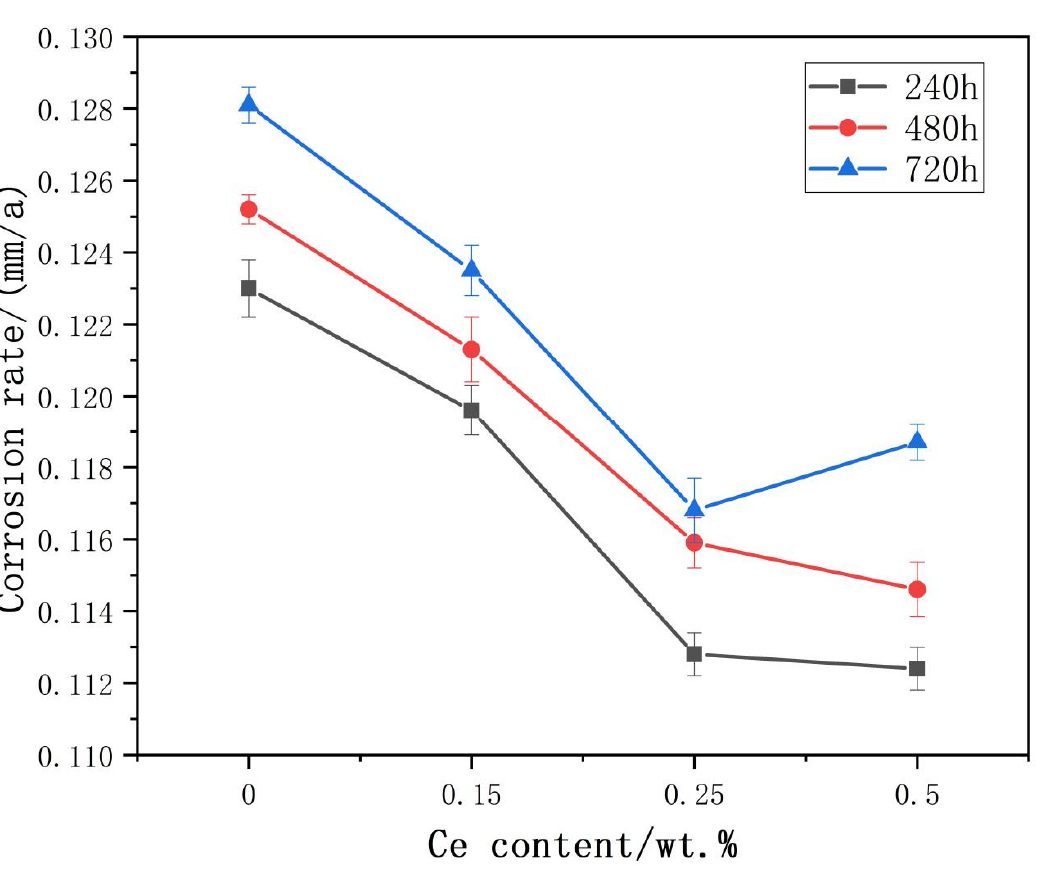
Figure 4. Corrosion rate diagram of Al-5Mg-3Zn-1Cu alloy with different Ce content.